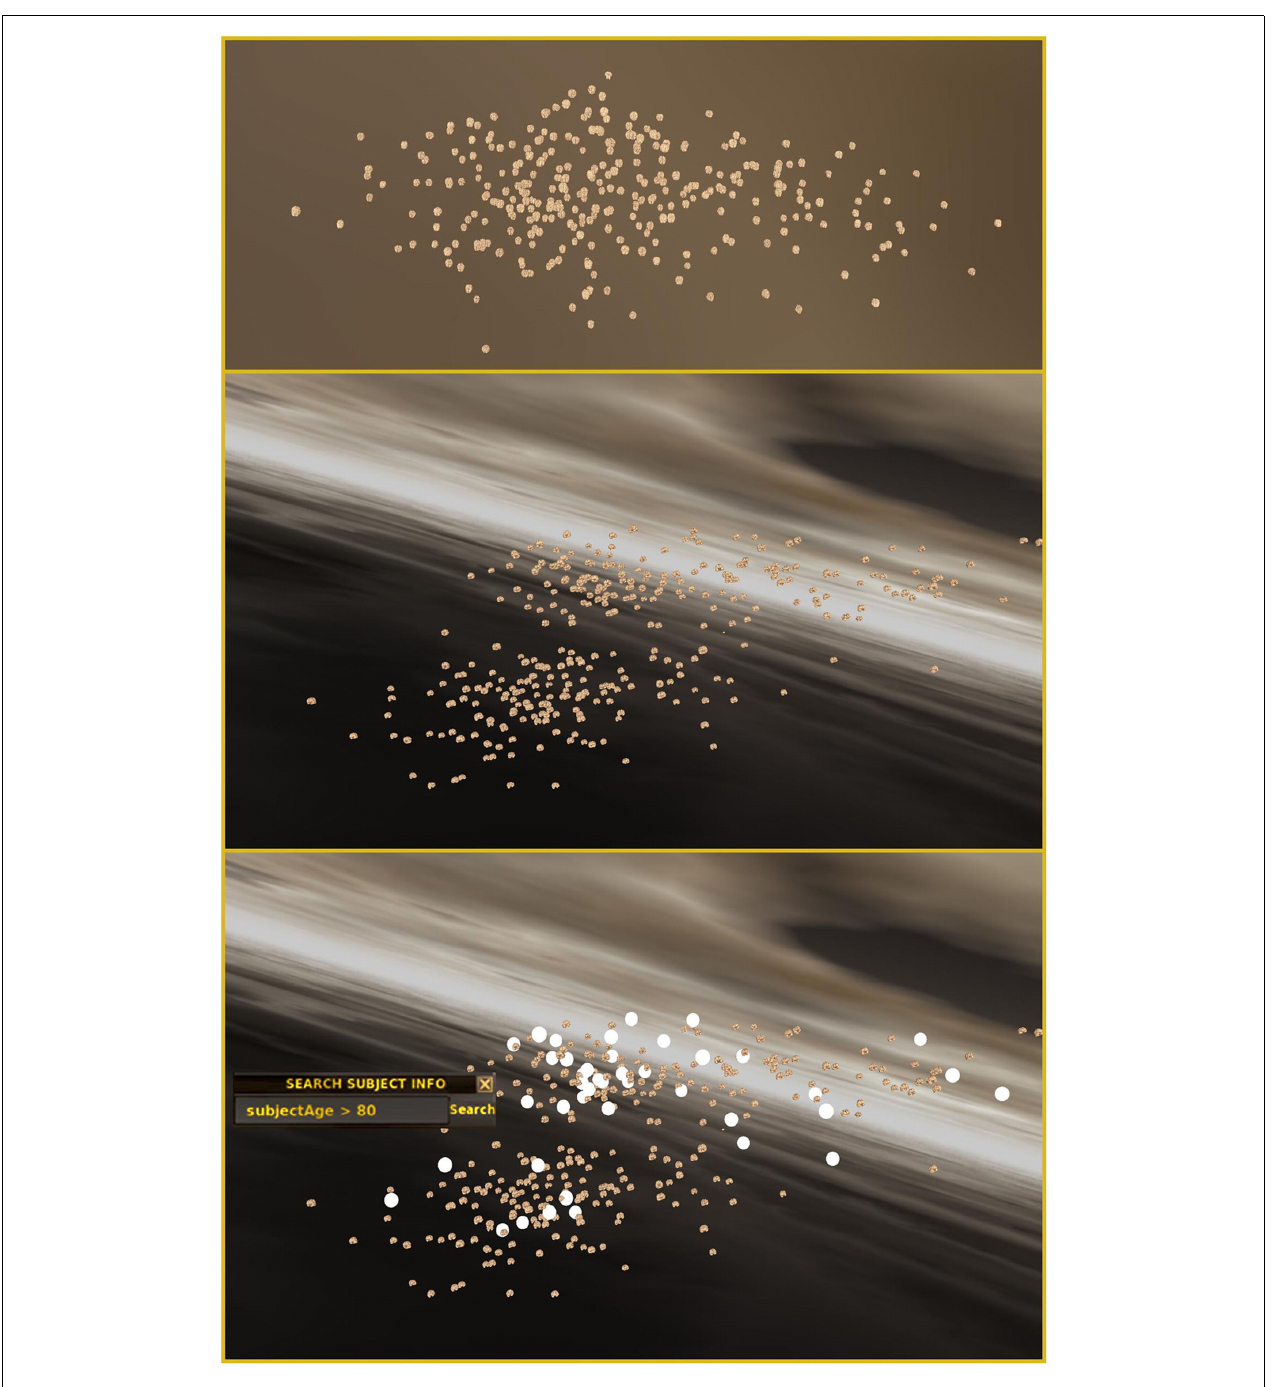
“Subject Age > 80,” reveals that there appears to be an age related component to the clustering (Bottom). A user-selectable skybox background aids with the perception of the 3D space, relative distance, depth, and motion as the user navigates in the INVIZIAN